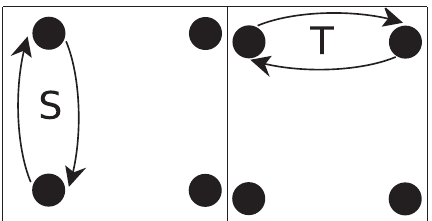
FIG. 6. Generators S and T of all gates that can be performed on a qudit stored in the fusion space of four parafermions by braiding